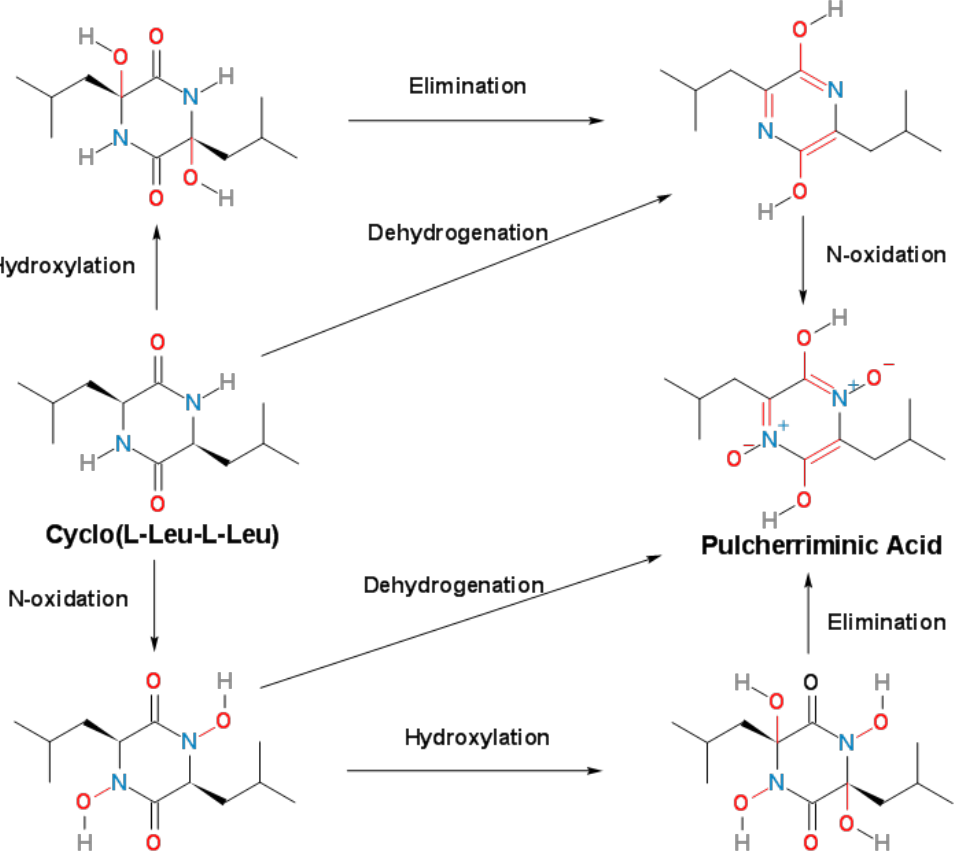
Figure 8. Possible mechanism of cytochrome P450 oxidase CypX that catalyzes cLL to form pulcherriminic acid [3].